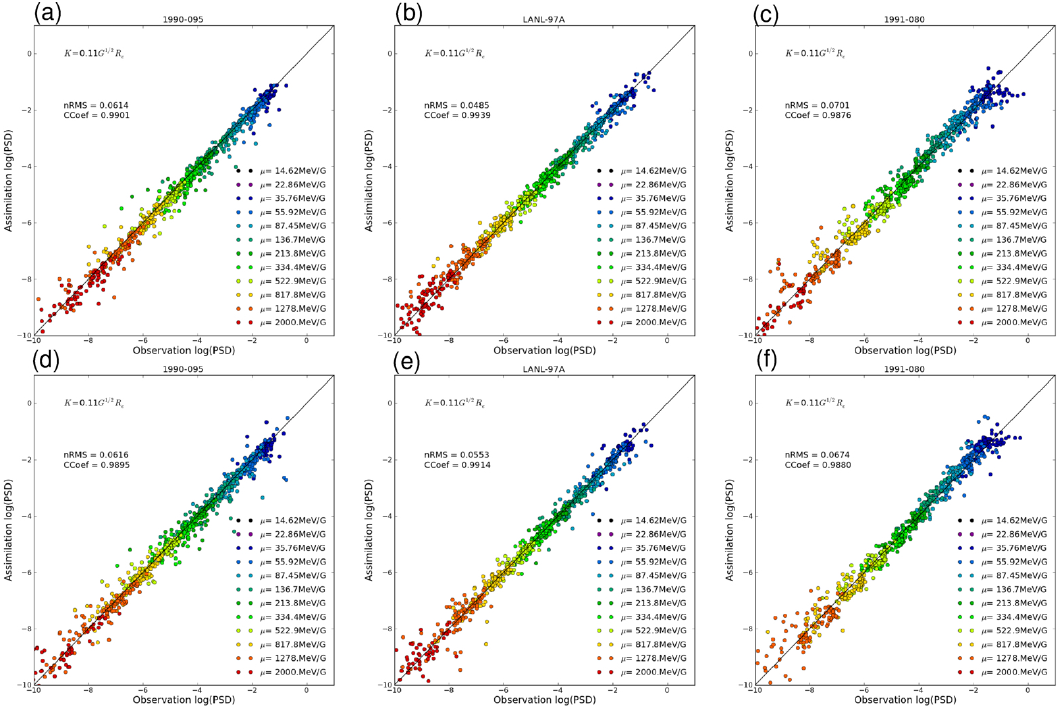
Fig. 4. The assimilated PSD ( y axis) and the observed PSD ( x axis) for various µ values and K ’ 0.1 G 1 / 2 R E . The observed PSD for the first two columns is obtained from two satellites (1990-095, LANL-97A), used as input in the assimilation. The PSD data on the right column are from an independent satellite (1991-080) that does not participate in the assimilation. The top row is for the assimilation using the RAM-SCB magnetic fields, and the bottom row is for the assimilation using T01S magnetic fields. The normalized root-mean-square (nRMS) error and the cross-correlation coefficient are denoted in each